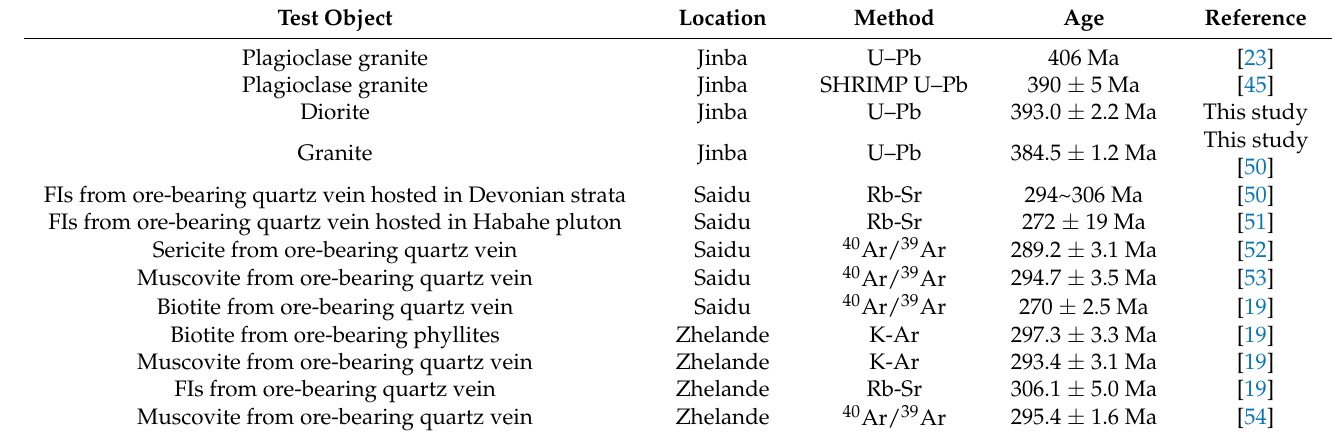
Table 4. Isotopic ages of rocks and minerals from the Jinba gold